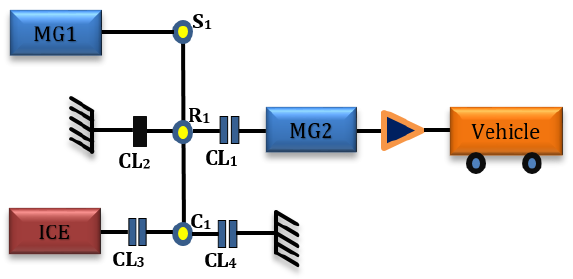
Figure 2. Topology of the drivetrain with one planetary gear used in this